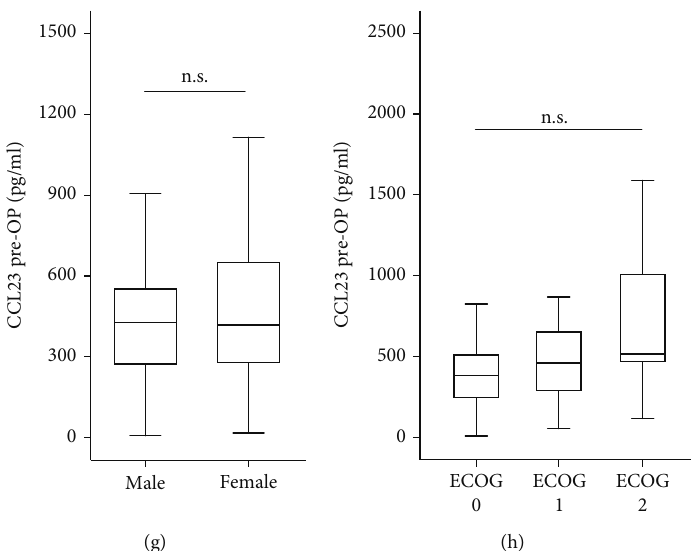
Figure 2: CCL23 serum levels and baseline characteristics. Baseline CCL23 levels are unaltered between BTC patients of di ff erent tumor localization (a), T-stage (b), M-stage (d), tumor grading (e), or resection status (f). (c) BTC patients with nodal positive disease (N1) have signi fi cantly lower CCL23 levels. CCL23 levels are unaltered between male and female patients (g) as well as patients with di ff erent ECOG performance status (h).